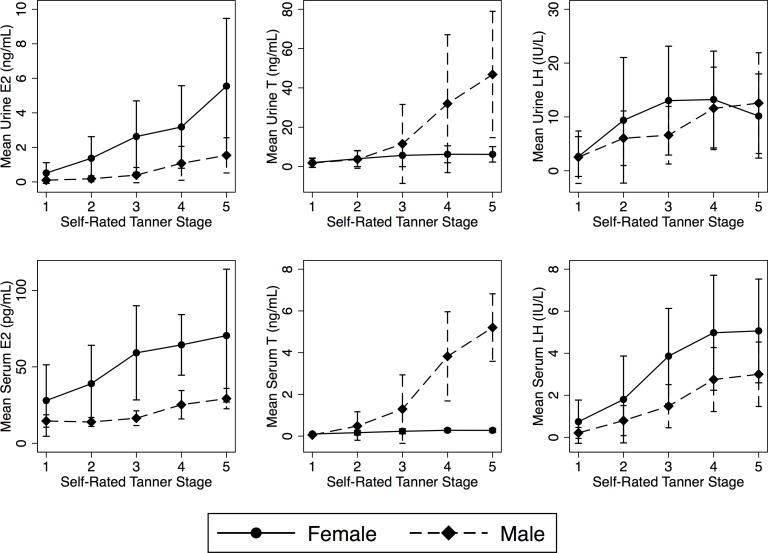
Plots of mean and SD E2 (left), T (centre) and LH (right) in urine (top) and serum (bottom) specimens, by Tanner stage.